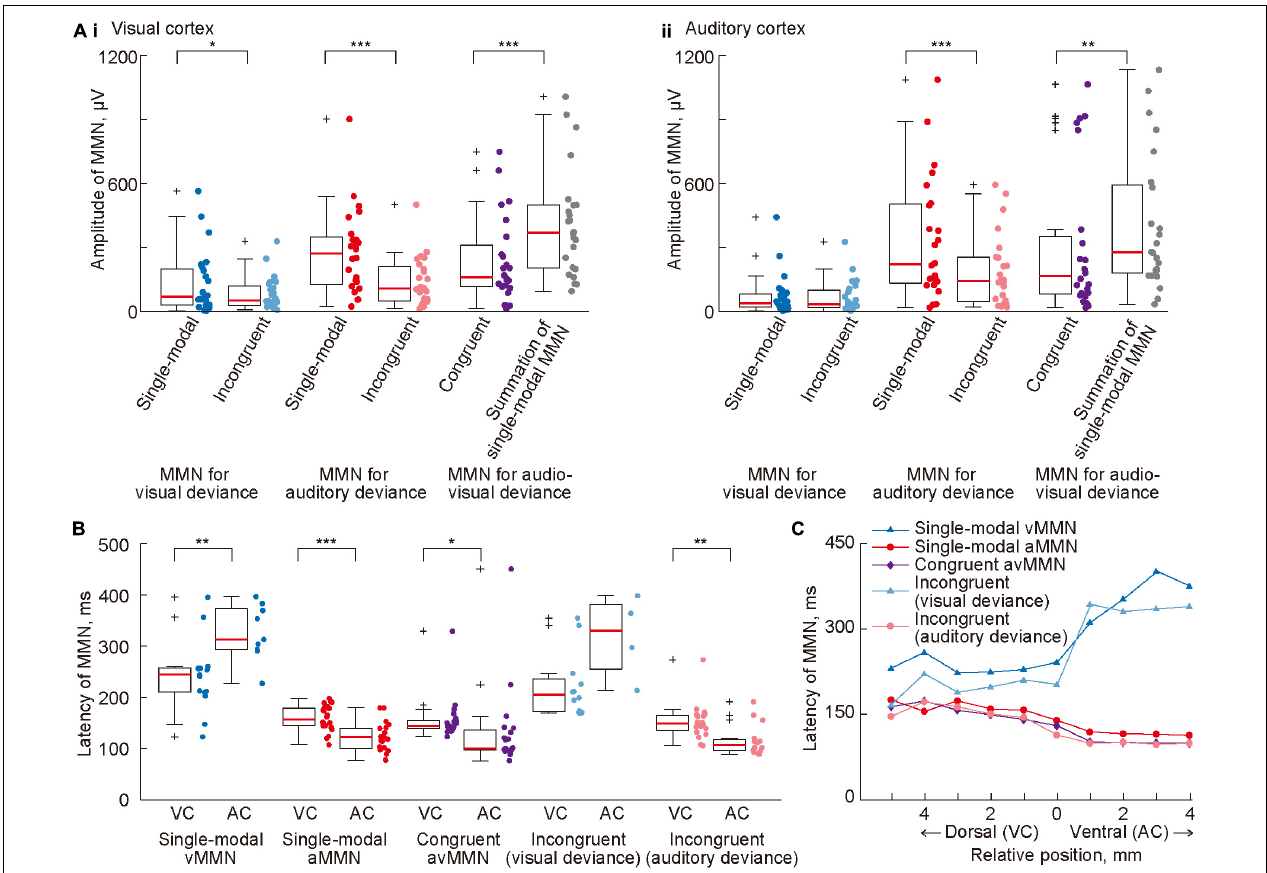
FIGURE 5 | Cross-modal effect on mismatch negativity (MMN) amplitude and latency. (A) Mean amplitude of MMN in (i) the visual and (ii) auditory cortices, quantified in all tested paradigms. For comparison, the sum of vMMN and aMMN in the single-modal oddball paradigm is also shown (rightmost). (B) Comparison of mean MMN latency in the putative visual cortex (VC) and the putative auditory cortex (AC). (C) Propagation of MMN. The median latency of MMN in each row of the recording site was plotted with respect to the relative vertical position from the most ventral row of the putative visual cortex. In panels (A,B) , dots indicate the mean amplitudes of MMN in each putative region in individual animals. Asterisks indicate statistical significance: * p < 0.05; ** p < 0.01; *** p < 0.001 (Wilcoxon one-sided signed-rank